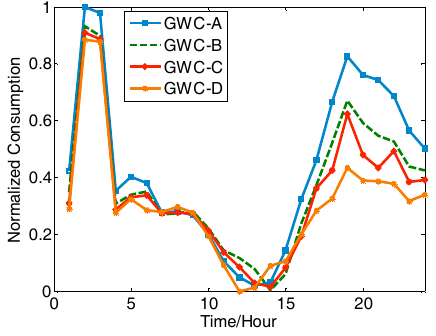
Figure 11. The simulated TNLPs of a customer with a household ESD.